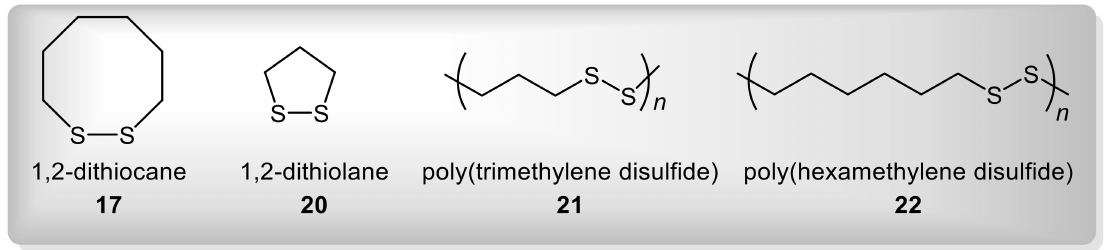
Figure 9. Structures of cyclic and polymeric disulphides 17 and 20 – 22 used in the